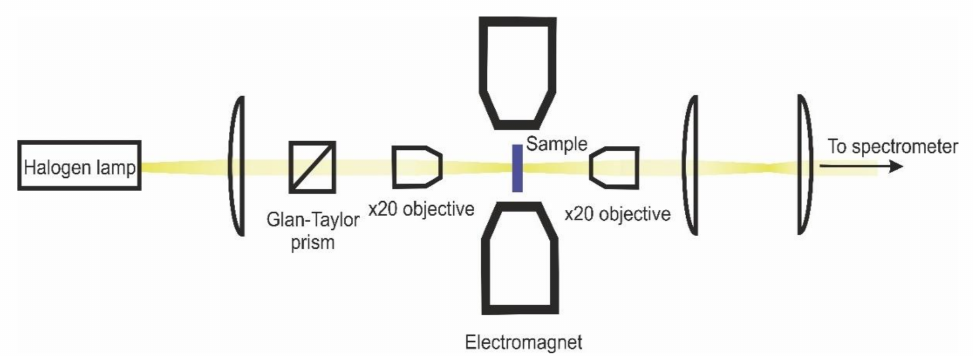
Figure A4. Schematic of TMOKE setup used in the